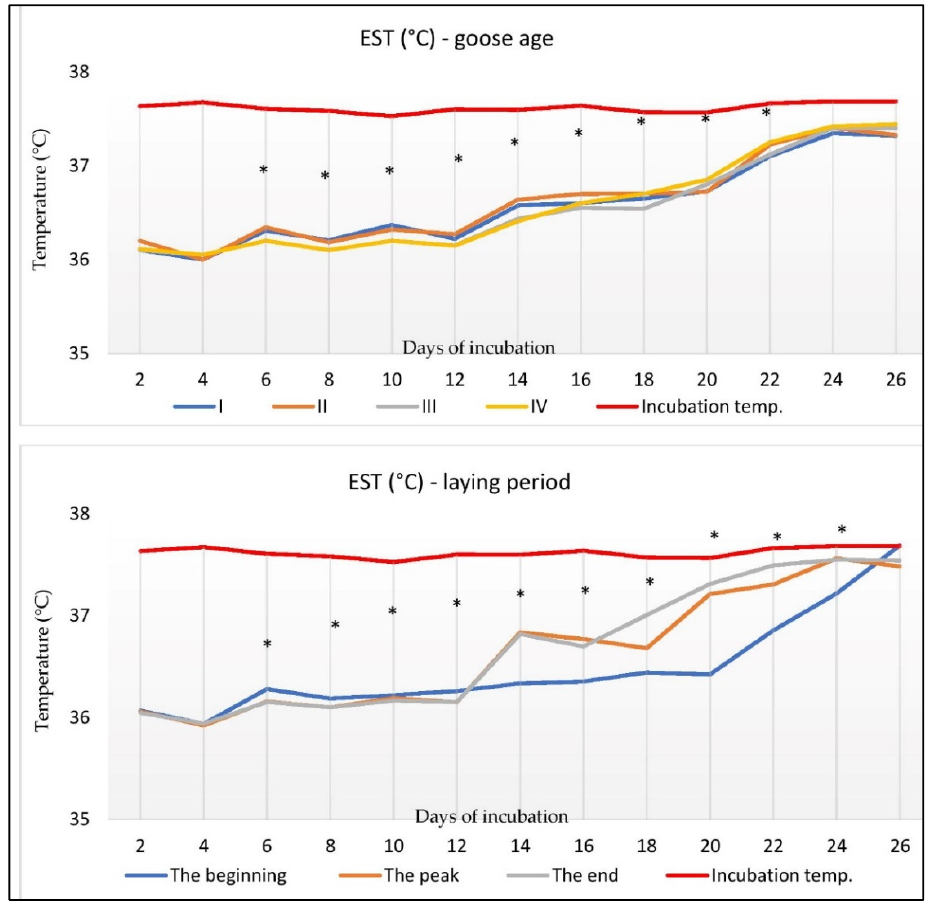
Figure 2. The eggshell surface temperature (EST) of goose eggs during incubation depends on the age of the females and the laying period. *, mean values differ significantly ( p < 0.05); I, 1-year-old geese; II, 2-year-old geese; III, 3-year-old geese; IV, 4-year-old geese; n = 15/per group.